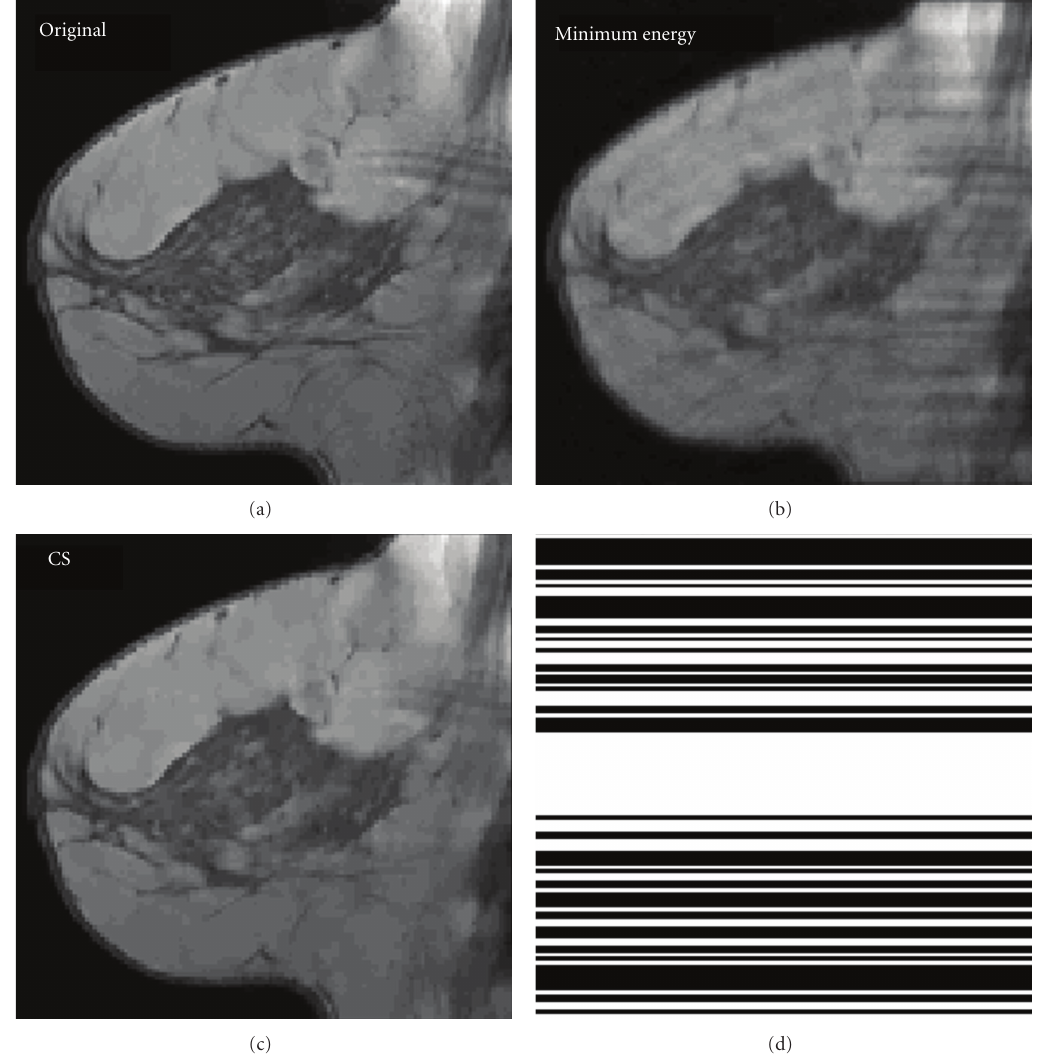
Figure 1: Sample reconstructions from the timing experiment. (a) shows the original T 1 -weighted breast image, (b) is the result of replacing the missing Fourier coe ffi cients with zeros (minimum energy reconstruction), and (c) shows the CS reconstruction. (d) shows the 50% undersampled pattern of Fourier data retained (white is acquired; black is omitted). Entire lines of the Fourier domain were chosen to be consistent with the constraints of a 2D MRI acquisition.